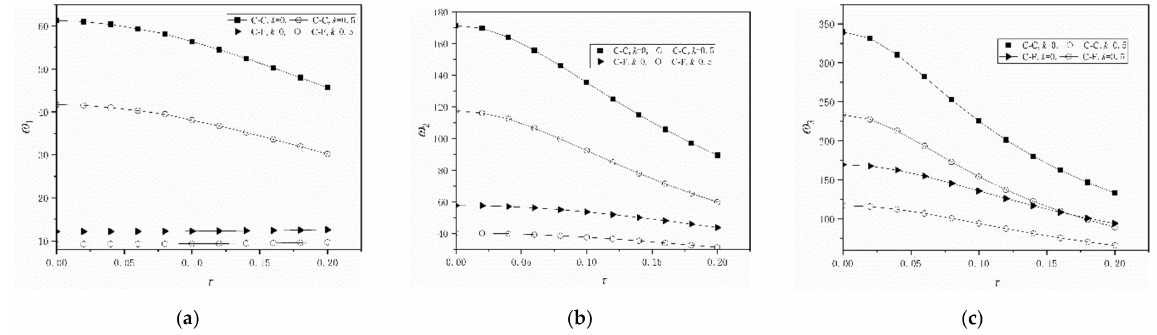
Figure 5. The relationship between dimensionless natural frequencies and the nonlocal parameter under two different boundary conditions (Kirchhoff plate). ( a ) The first-order frequencies; ( b ) The second-order frequencies; ( c ) The third-order frequencies.